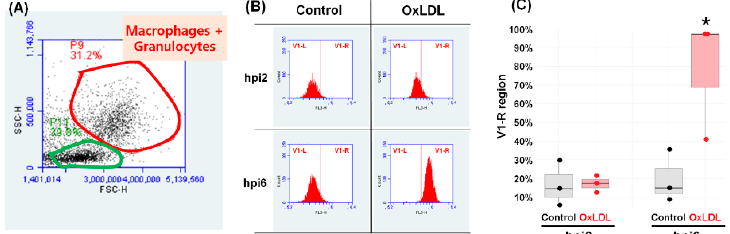
Figure 5. Scattergram of side scatter (SSC) plotted against forward scatter (FSC) of leukocytes isolated from the head kidney. Panel ( A ) represents the P 9 region (red line) and the P 11 region (green line), indicating macrophage and lymphocyte populations, respectively. ( B ) Nile-Red fluorescence (FL-3 fluorescence) of the macrophage and granulocytes (P9-gated cells) in the control and OxLDL group at 2 and 6 hpi. ( C ) The percent of macrophages and granulocytes (P9-gated cells) in the control and OxLDL groups with high Nile Red a ffi nity (V1-R region). The results are presented as the mean ± S.D. * indicates a significant di ff erence of p < 0.05 based on the student’s t